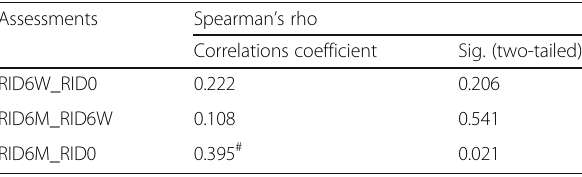
Table 8 Correlation analysis of RID change with respect